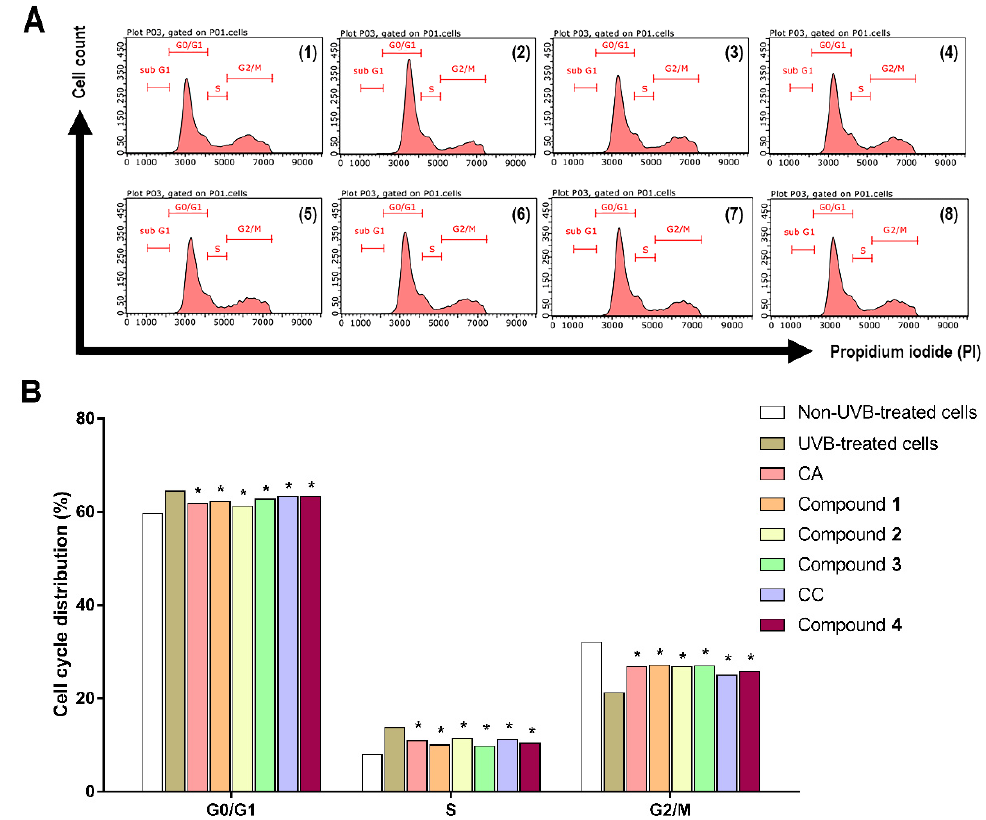
Figure 9. Cell cycle arrested following CA and CC extracts and isolated compounds treatments for 48 h. 0.1% DMSO was used as a control. The cell cycle was analyzed using flow cytometry. Human keratinocytes were pre-treated with the tested samples for 24 h. The cells were harvested, stained with propidium iodide (PI) for 24 h after the tenth UVB irradiation (100 mJ cm − 2 ) and DNA content was quantified by flow cytometry. ( A ) Data shows the gating histogram showing the percentage of cells in the G0/G1, S and G2/M phases of the cell cycle obtained after flow cytometry analysis, where (1) = non-UVB-treated cells, (2) = UVB-treated cells, (3) = CA extract, (4) = compound 1 , (5) = compound 2 , (6) = compound 3 , (7) = CC extract and (8) = compound 4 . For each sample, 500,000 cells were acquired. ( B ) Cell cycle distribution pre-treated compounds treatments. Data are presented as the means ± SD. Asterisks (*) denote significant differences from the UVB-treated group ( p < 0.05).